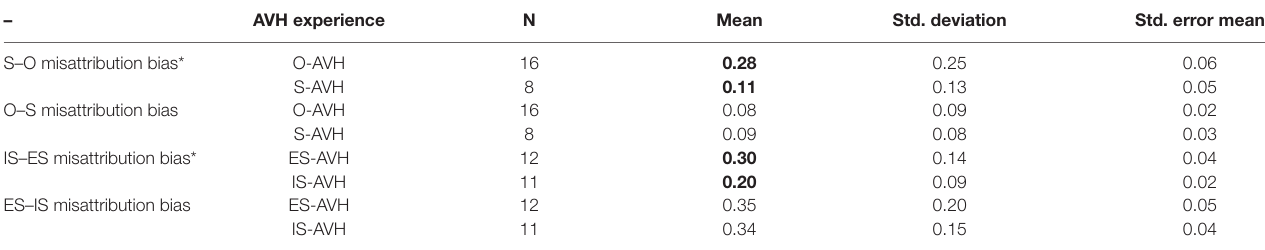
TABLE 5 | Comparison of S–O and O–S misattribution biases between subgroups of patients defined according to AVH phenomenology: O-AVH, S-AVH (upper panel). Comparison of IS–ES and ES–IS misattribution biases between subgroups of patients defined according to AVH phenomenology: IS-AVH, ES-AVH (upper panel).